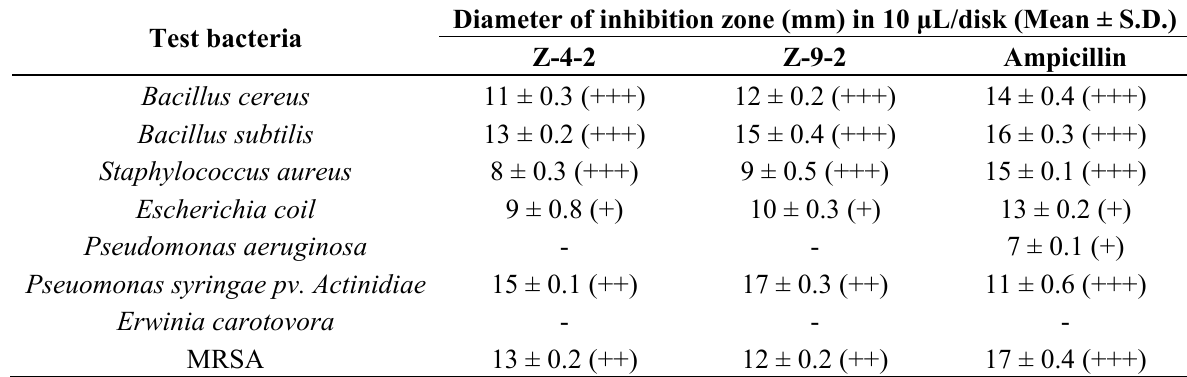
Table2. Antibacterial activities of compounds Z-4-2 and Z-9-2 in vitro . Test